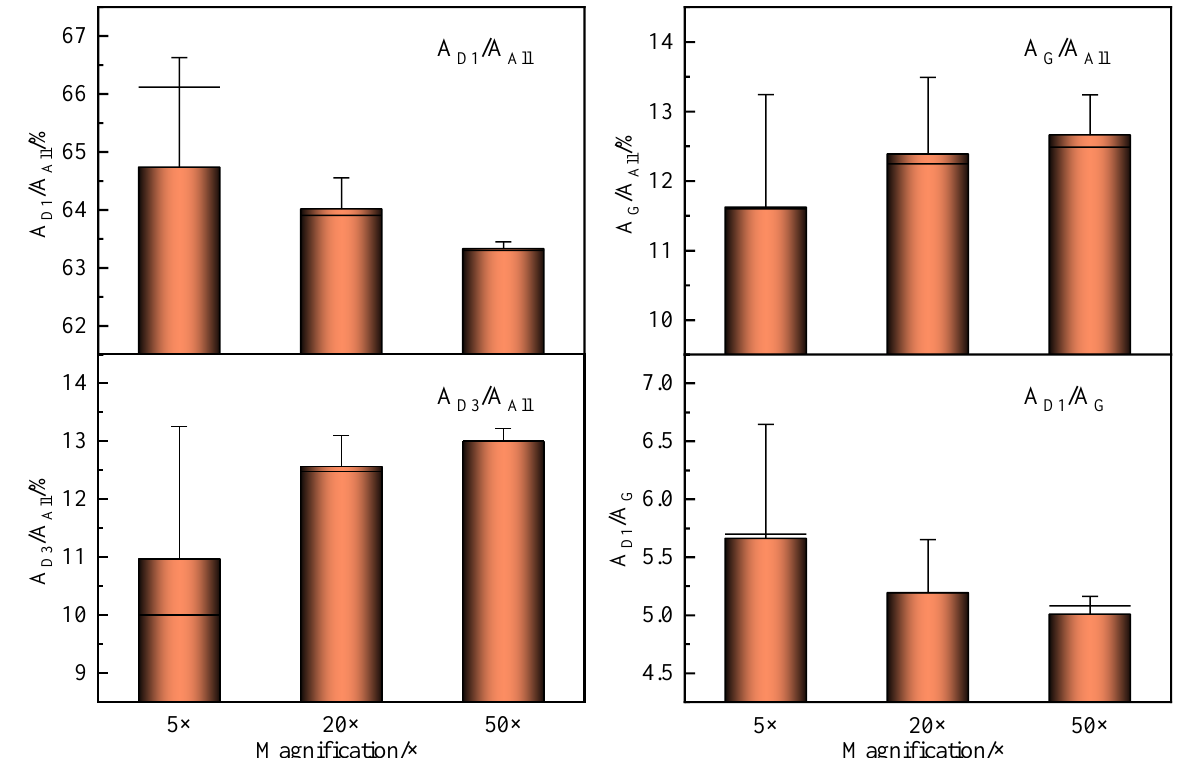
7 of 16 Figure 3. Raman peak intensity for char1 with a particle size of 61 – 75 μm for different objective lens magnifications. Figure 4 presents the Raman characteristic parameters of char1 for different objective lens magnifications. It can be seen from Figure 4 that as the objective lens magnification increases, the Raman characteristic parameters A D1 /A All and A D1 /A G show a decreasing trend, whereas A G /A All and A D3 /A All show an increasing trend. Although the Raman char- acteristic parameters reflect a certain variation mechanism, the difference is relatively small. However, there is an obvious phenomenon that can be observed: the stability of Raman characteristic parameters corresponding to different objective lens magnifications is quite different. When the objective lens magnification is higher, the stability of the Ra- man characteristic parameters is increased. A possible reason for this phenomenon is as follows: when the objective lens magnification is lower, the diameter of the corresponding